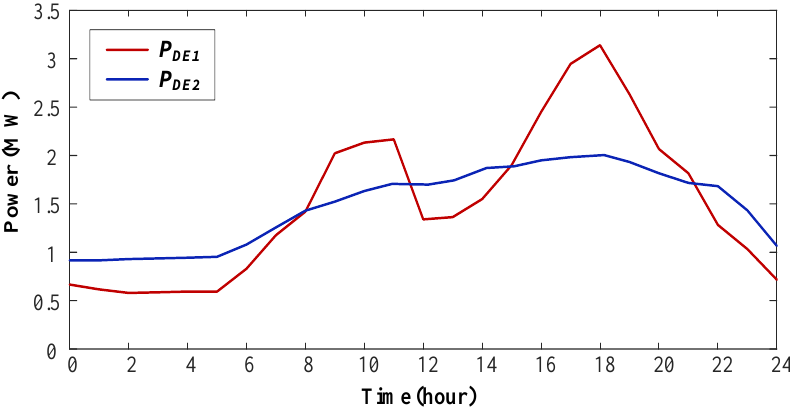
Figure 8. Output power of the diesel generator before and after cooling loads were independently considered.